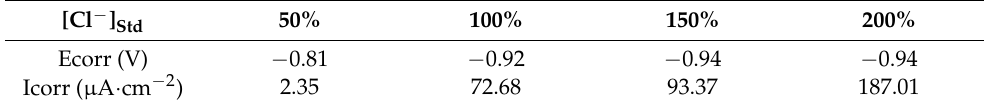
Figure 1. Potentiodynamic polarization curves at different Cl − concentrations. Table 3. The fitting data of the potentiodynamic polarization curve .